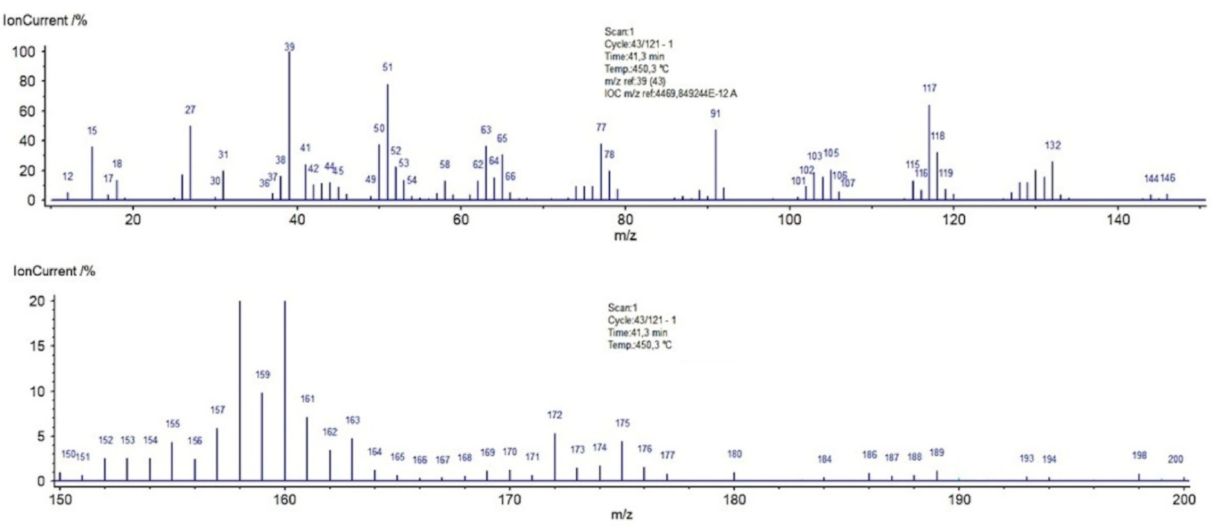
Figure 11. MS spectra of DVB:TEVS = 1:1 decomposition at 450 ◦